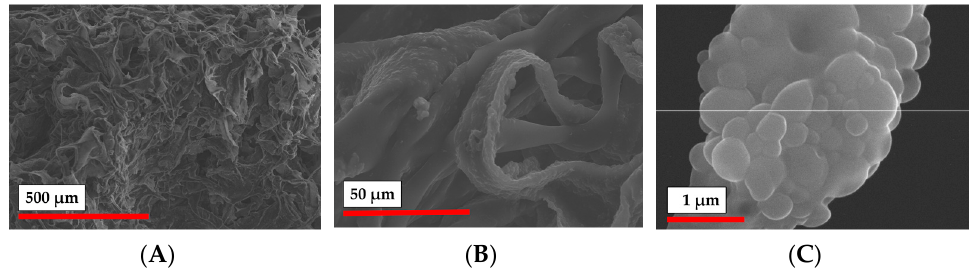
Figure 11. SEM images of PLA-MA NPs/NCC-MA 3D-printed matrix: ( A ) ×100; ( B ) ×1000; ( C ) ×30 000.